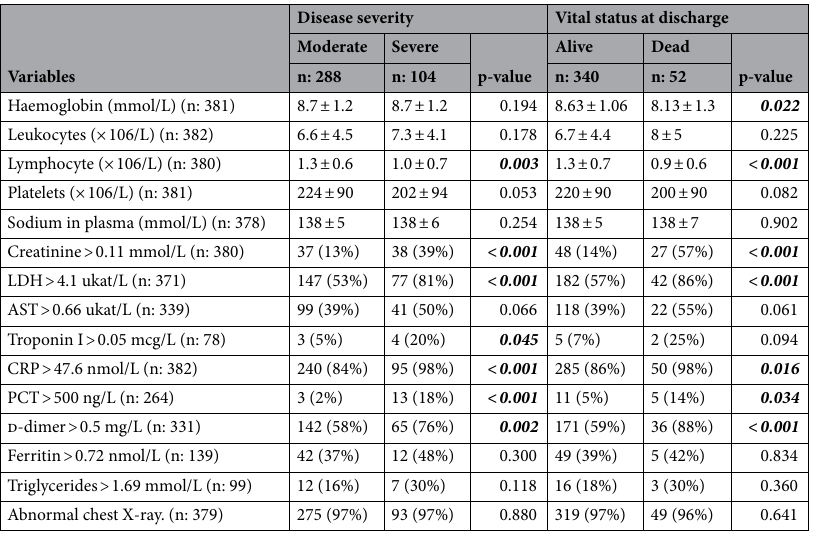
Table 3. Laboratory and radiology at admission. Bivariate analysis according to whether they developed severe disease, and status at discharge. In each variable, total number of valid data is specified in the first column. In each outcome, absolute frequency and percentage by outcome; or mean and Standard deviation are shown; as well as p-values for the comparation of moderate vs severe disease and alive vs dead at discharge. In bold and italic those associations that are statistically significant.